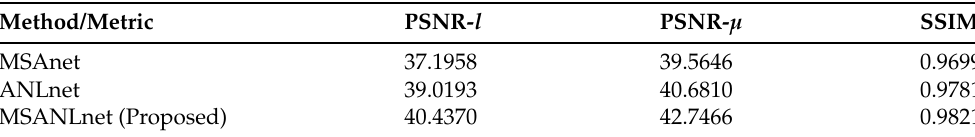
Table 2. Quantitative comparison of the performance of the proposed method (MSANLnet) and its baseline variants.